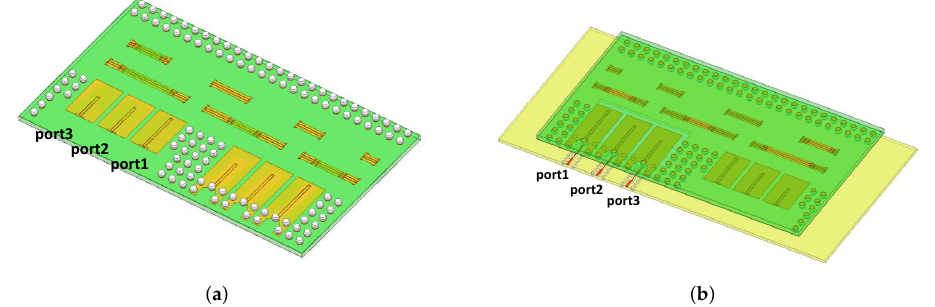
Figure 12. Three-dimensional model of the designed structures for the port reduction technology. ( a ) Model without test board, ( b ) model with test board.